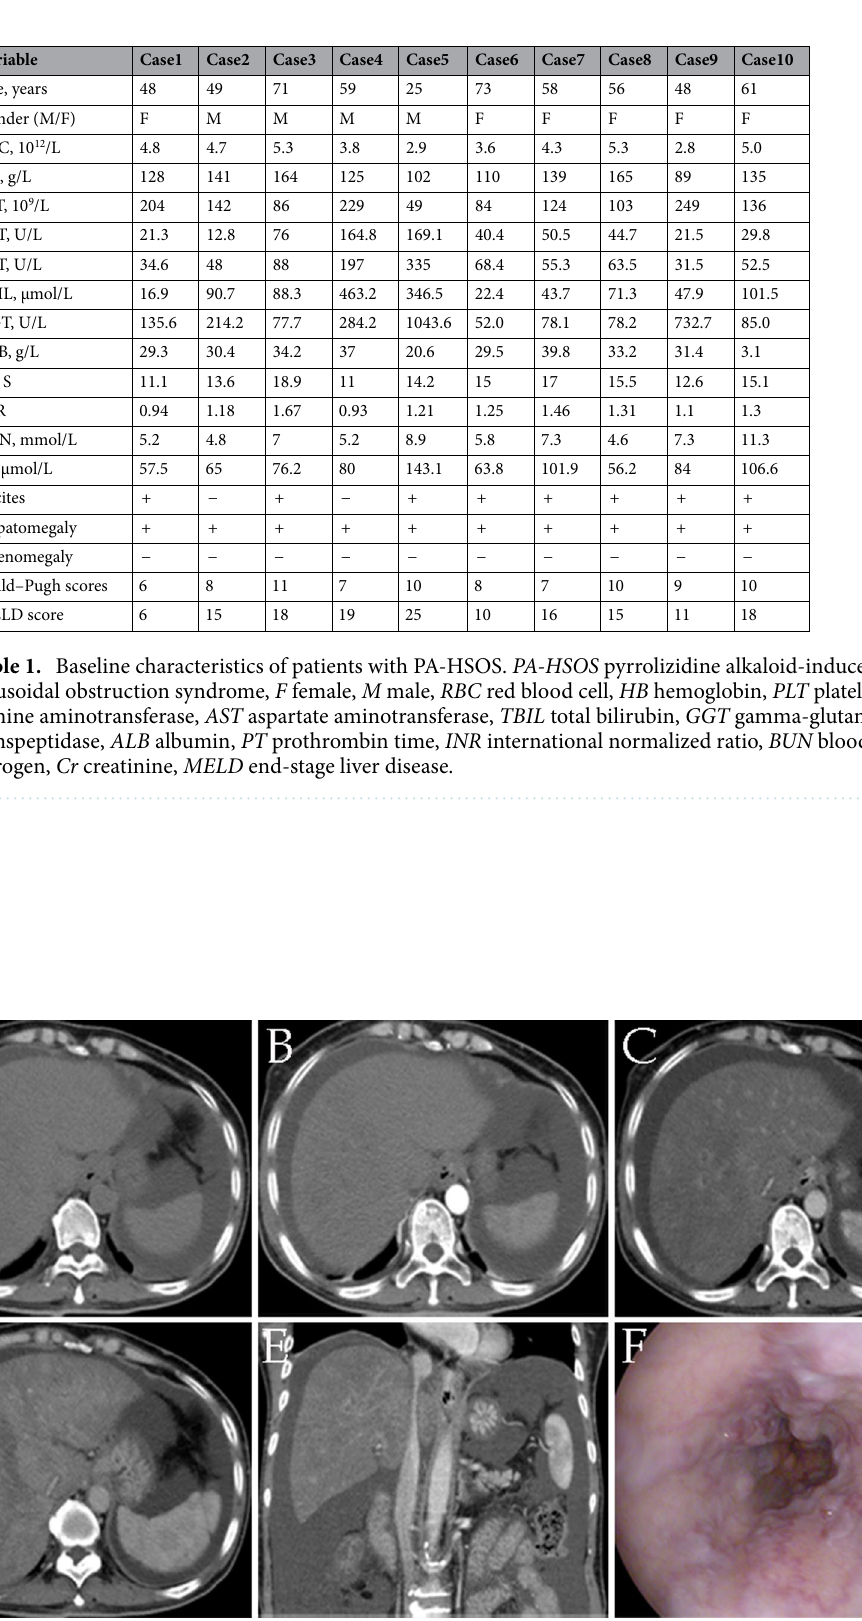
Figure 2. A 61-year-old woman diagnosed with pyrrolizidine alkaloid-induced hepatic sinusoidal obstruction received contrast-enhanced CT scan and gastroscopy. ( A–D ) Images from plain and contrast-enhanced CT scan. ( A ) Plain CT scan; ( B ) arterial phase; ( C ) portal phase; ( D ) equilibrium phases. ( E ) Multiple planar reconstruction CT showed that the hepatic segment of the inferior vena cava was compressed and thinner. ( F ) Gastroscopy revealed esophageal varices. CT computed